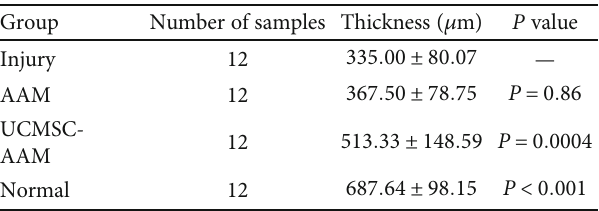
Table 2: Endometrial thickness in the groups ( (cid:1) X ± S ). Group Number of samples Thickness ( μ